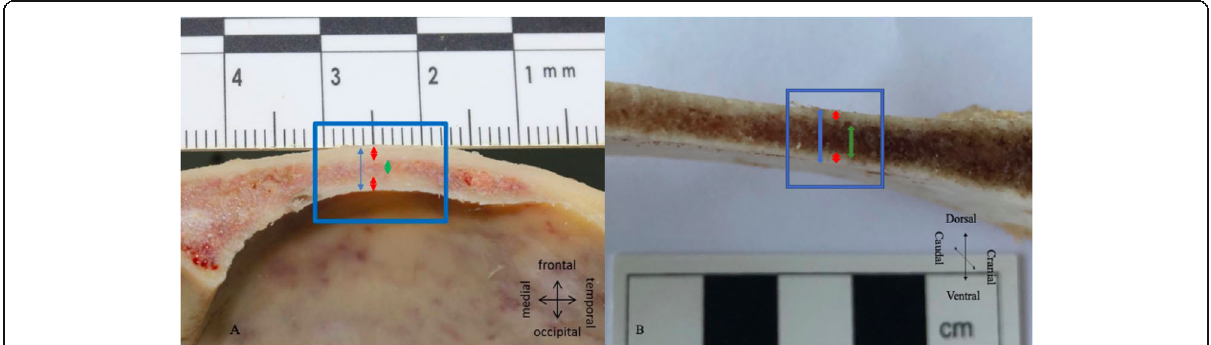
Fig. 1 Representative photograph of a cross-section of human frontal bone ( a ) and Bos taurus scapulae ( b ) displaying the area of interest (blue box) and the distances measured: thickness in total (blue arrows), outer and inner cortical layers (red arrows) and cancellous bone (green arrows)